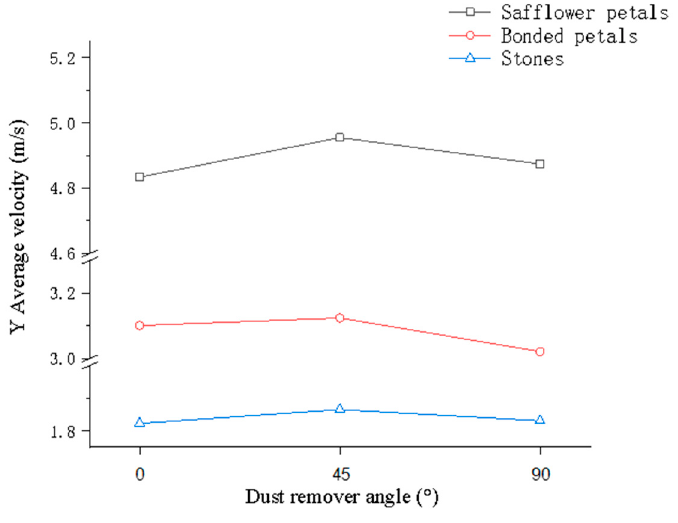
Figure 20. Influence of dust remover angle on the axial average velocity of the mixture components.